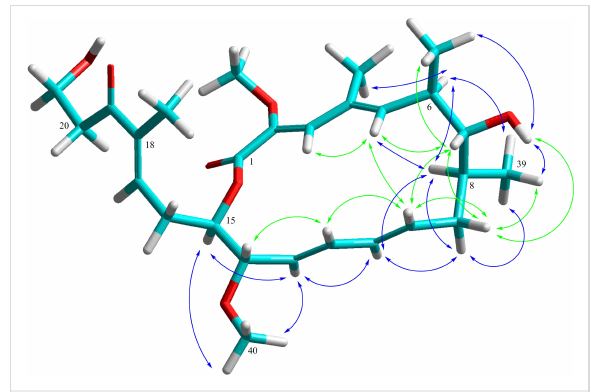
Figure 4: 3D Model of the macrolactone ring of lanyamycin ( 1 / 2 ) and selected ROESY correlations. Green arrows upper side NOEs, blue arrows under side NOEs.